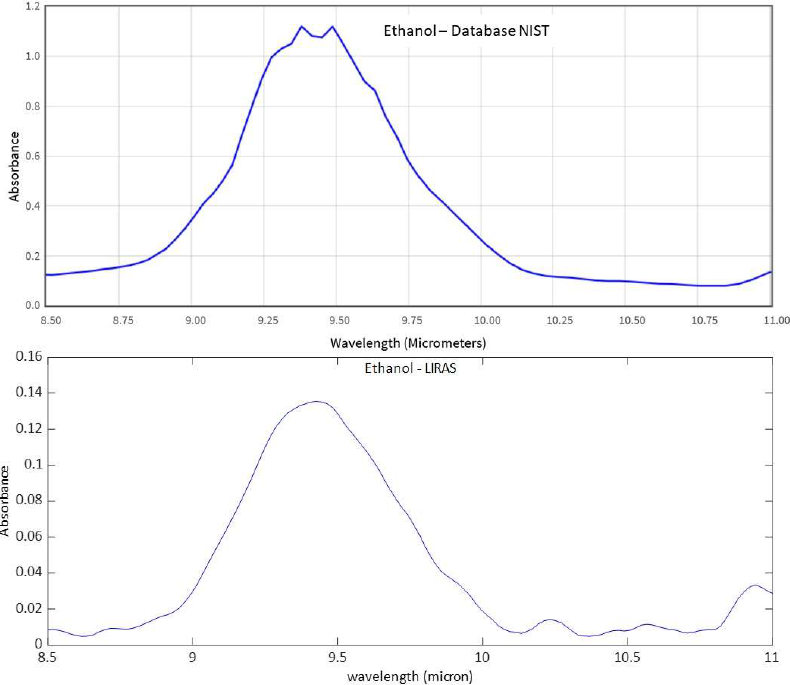
Figure 12. Comparison between the reference IR absorption spectrum of ethanol from the NIST database and the spectrum measured by the LIRAS sensor.